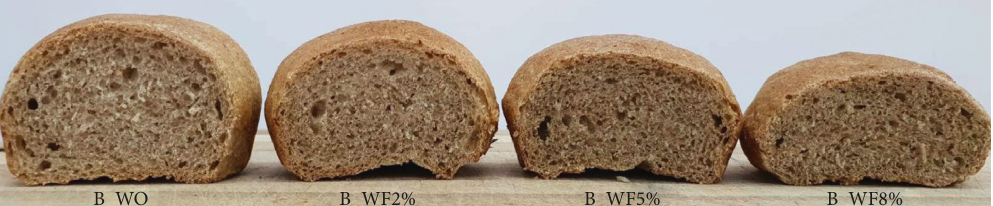
Figure 1: Sections of the obtained wheat-fenugreek bread samples as compared to a control dark wheat bread. B_WO flour+0% fenugreek flour; B_WF2% 98% wheat flour+2% fenugreek flour; B_WF5% (cid:30) B_WF8% 92% wheat flour+8% fenugreek (cid:30)